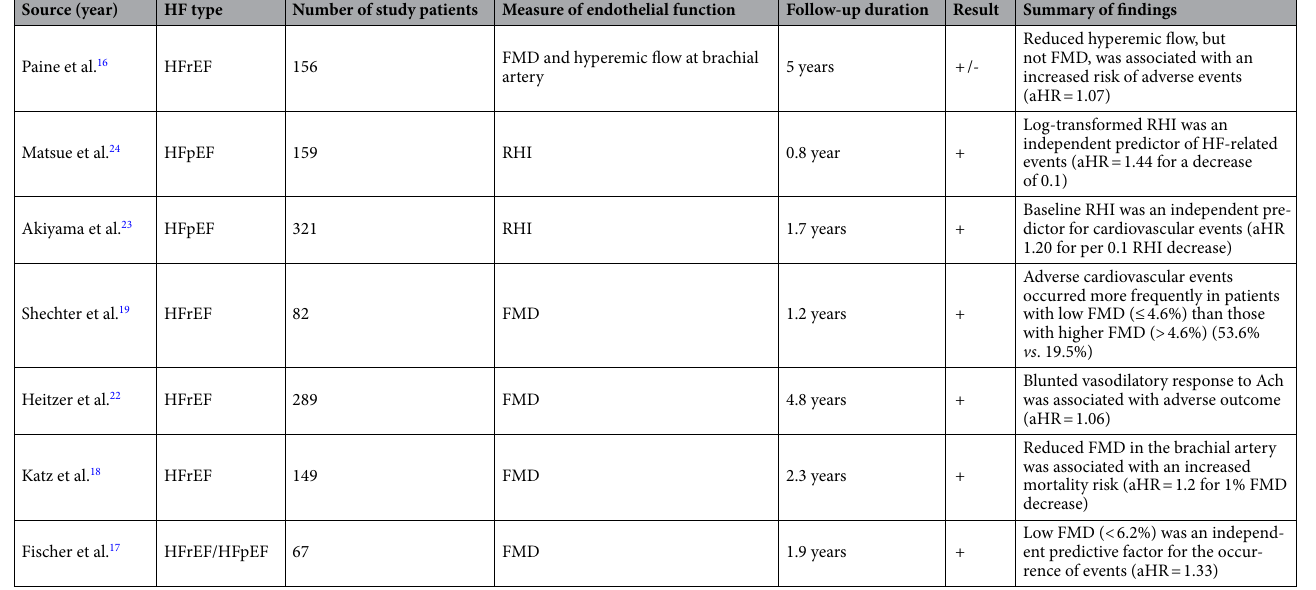
Table 4. Summary of studies showing the prognostic value of endothelial function in patients with HF. HF heart failure; HFrEF heart failure with reduced ejection fraction; FMD flow-mediated dilation; aHR adjusted hazard ratio; HFpEF heart failure with preserved ejection fraction; RHI reactive hyperemia